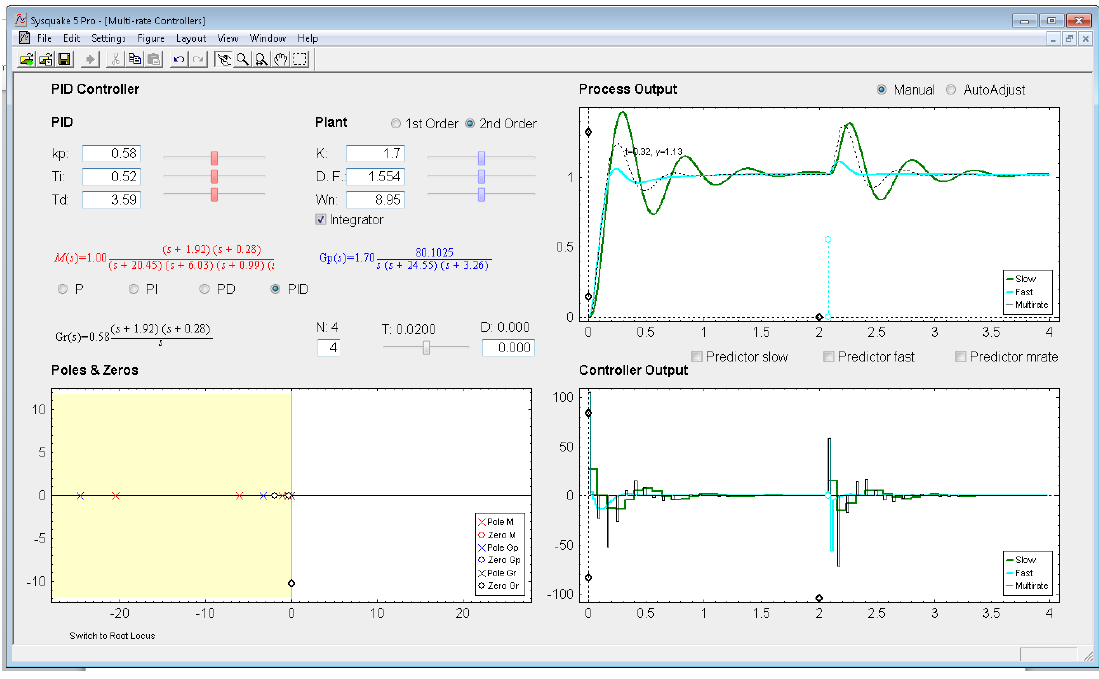
Figure 8. Application user interface for the PID